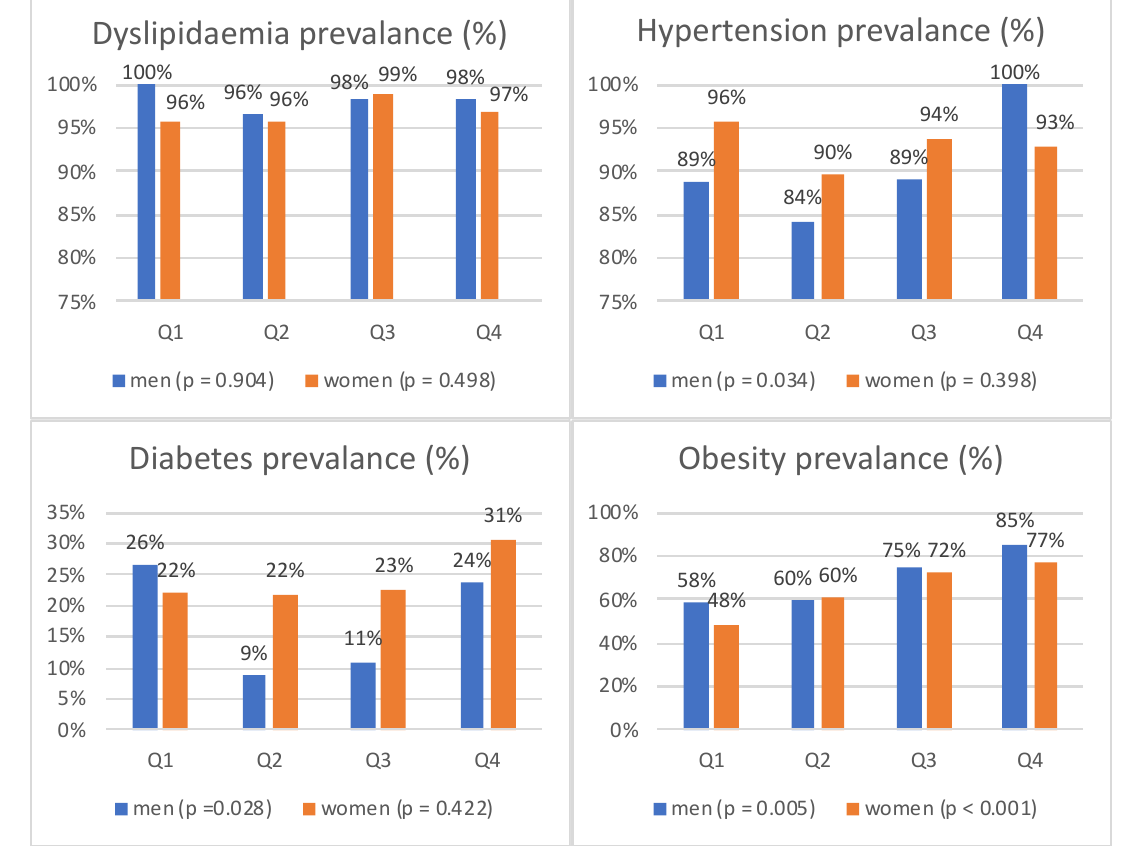
Figure 1. Prevalence of major cardiovascular disease risk factors in different levels of serum uric acid.